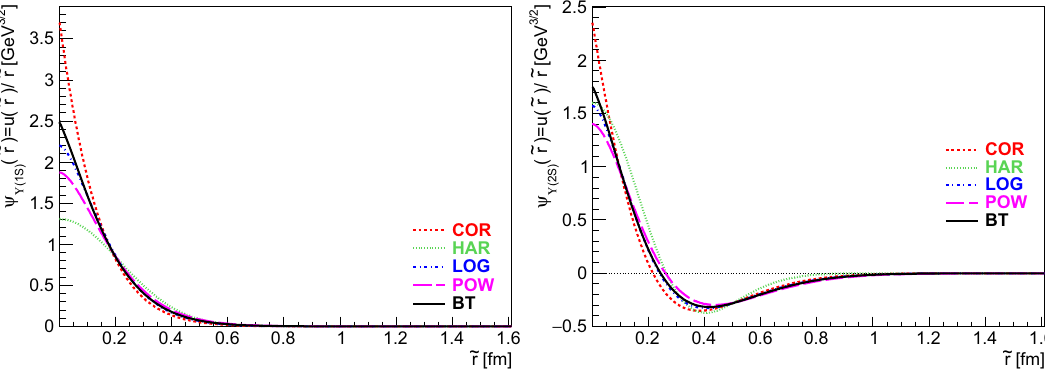
Fig. 29 The radial part of the wave function ψ( ˜ r ) for the ϒ( 1 S ) (left panel) and ϒ (cid:2) ( 2 S ) (right panel) mesons as a solution of the Schrödinger equation for five distinct b − ¯ b interaction potentials described in the Appendix